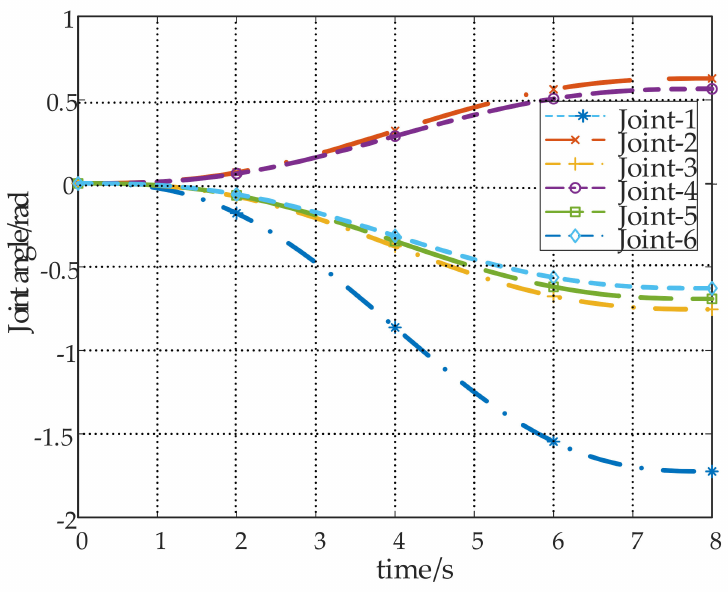
Figure 7. Variation of each joint angle of the left manipulator of the robot. After the collision experiment was carried out, the goal position was not